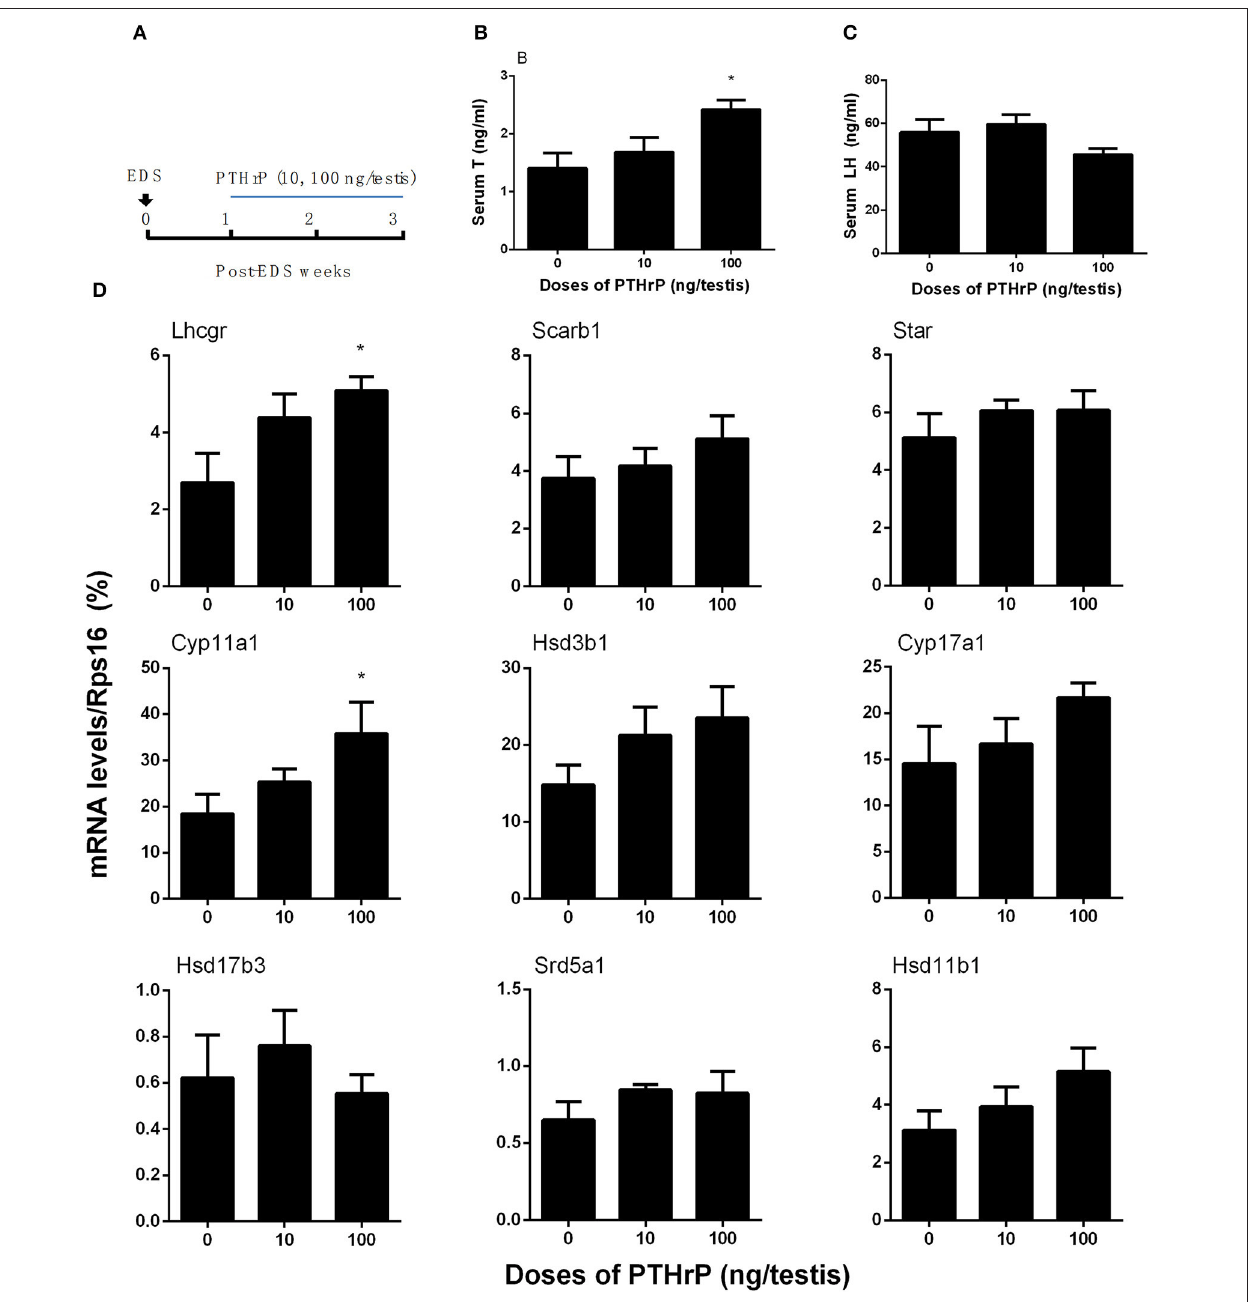
FIGURE 4 | PTHrP induces stem Leydig cell differentiation in vivo . Scheme of PTHrP-treated Leydig cell regeneration for 14 days (A) . Serum testosterone levels (B) and LH levels (C) . The mRNA levels of Lhcgr , Scarb1 , Star , Cyp11a1 , Hsd3b1 , Cyp17a1 , Hsd17b3 , Srd5a1 , and Hsd11b1 were analyzed by qPCR in the testes treated with 0, 10, and 100 ng/testis PTHrP for 14 days (D) . Mean ± SEM, n = 6, * P < 0.05 when compared to the control.